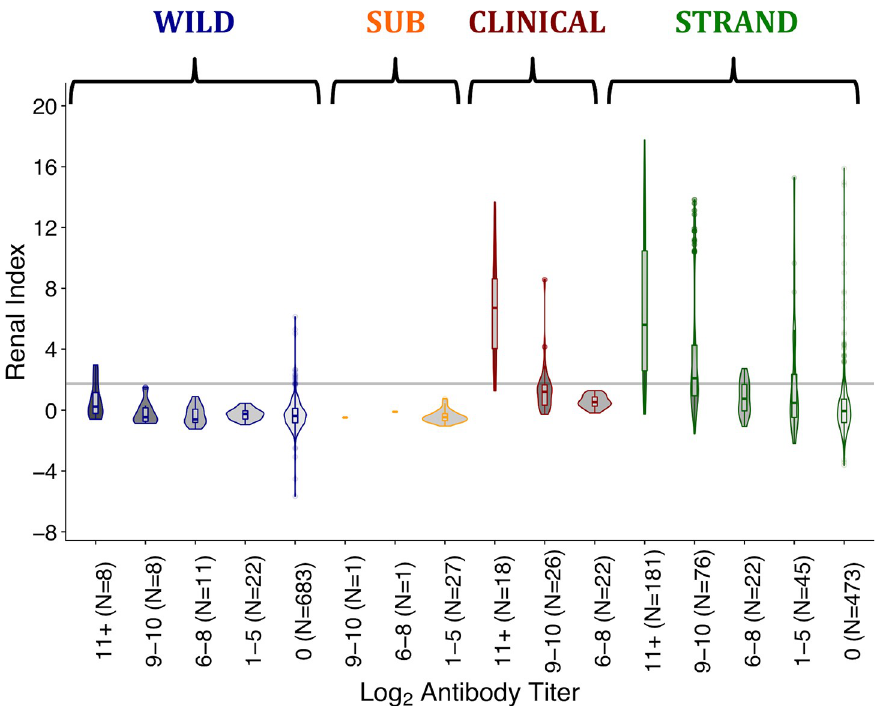
Fig 5. Renal index score distributions by log 2 antibody titer level, for each sample group. Sample groups are as described in the methods and are wild-caught (WILD), subclinical (SUB), clinical (CLINICAL), stranded (STRAND) sea lions. Titer groups were chosen based on the titer dynamics observed in the longitudinally followed animals through time. Groups roughly match the different phases of the host-pathogen relationship ranging from initial infection (11+), clinical recovery (9–10) and two stages of historic infection (1–5 and 6–8). Group 0 contains seronegative animals. The grey line denotes the upper boundary of the healthy range for renal index values. The upper whisker extends from the hinge to the highest value that is within 1.5 � IQR of the hinge, where IQR is the interquartile range. The lower whisker extends from the hinge to the lowest value within 1.5 � IQR of the hinge.